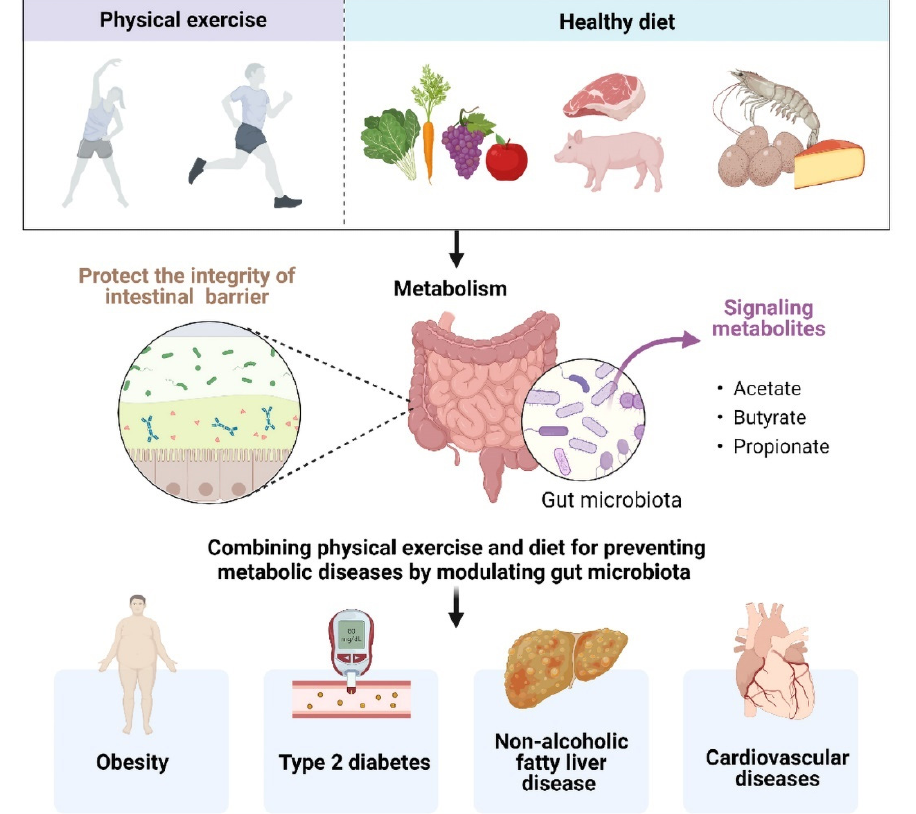
Figure 2. Combining physical exercise and diet for preventing metabolic diseases by modulating gut